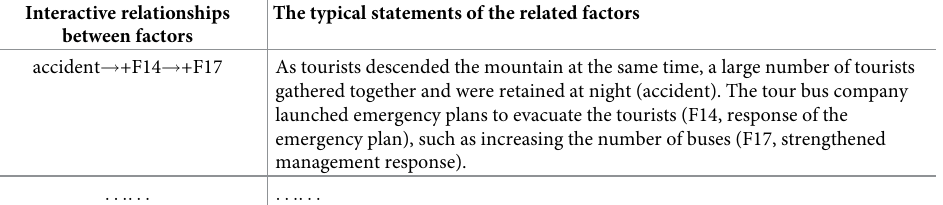
Table 4. The typical statements of the related factors and their interactive relationships of coping paths of the accidents. Interactive relationships between